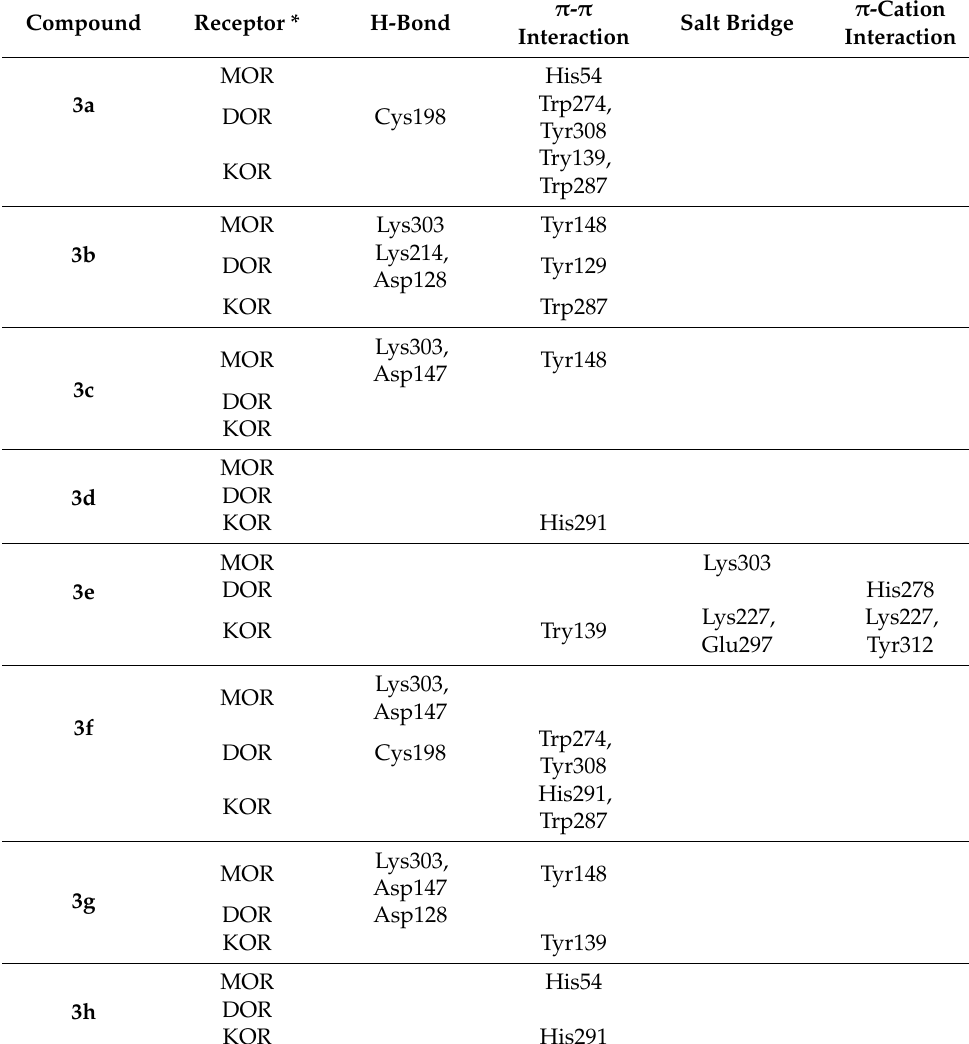
Table 3. Interaction sites of opioidergic receptor subtypes with the test